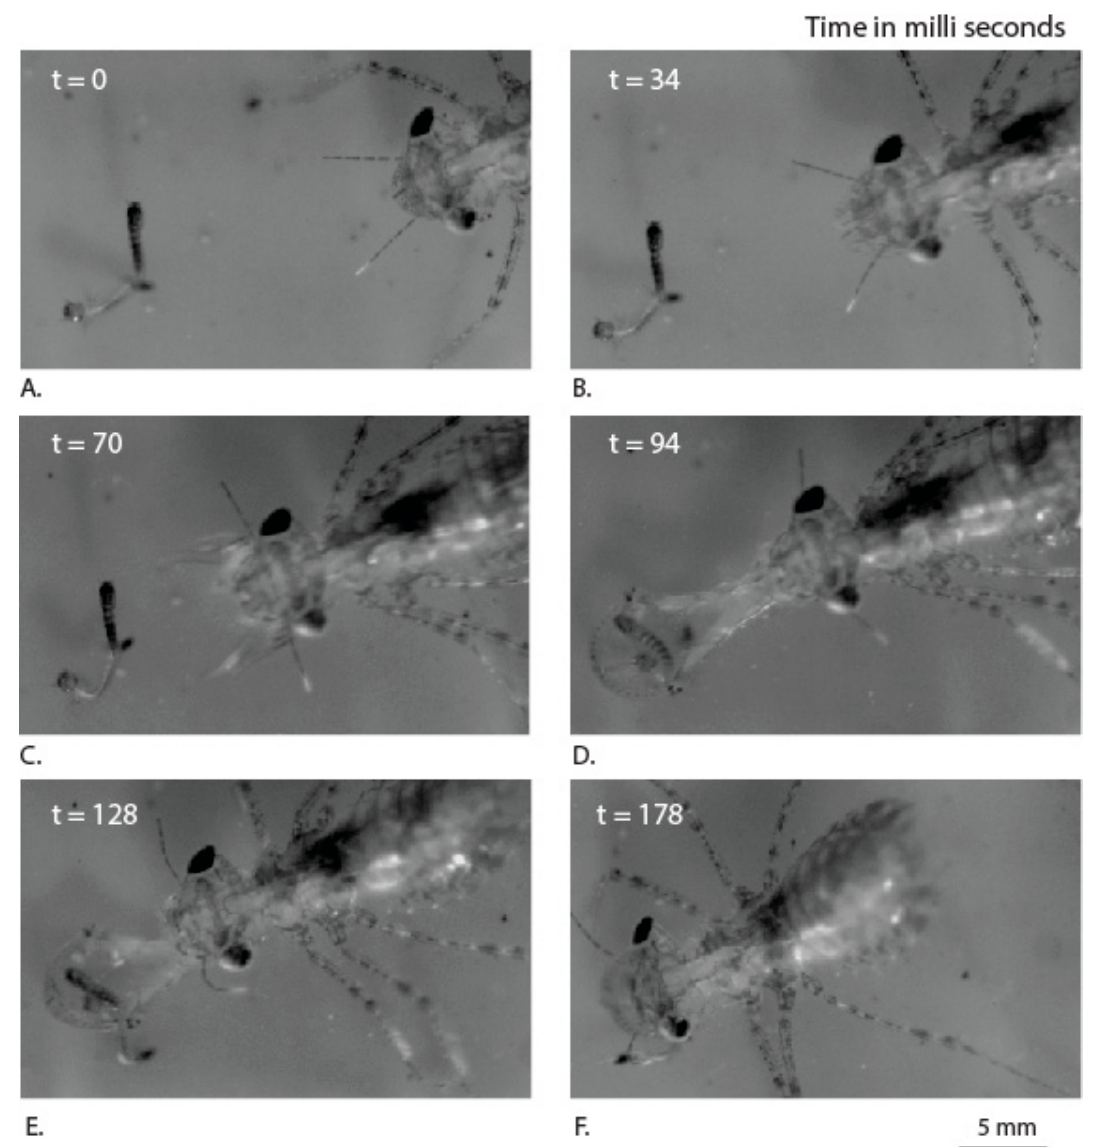
Figure 4. Sequence of movements (top view) used by the dragonfly nymph labium to capture the mosquito larva, at different time points ( A – F ).